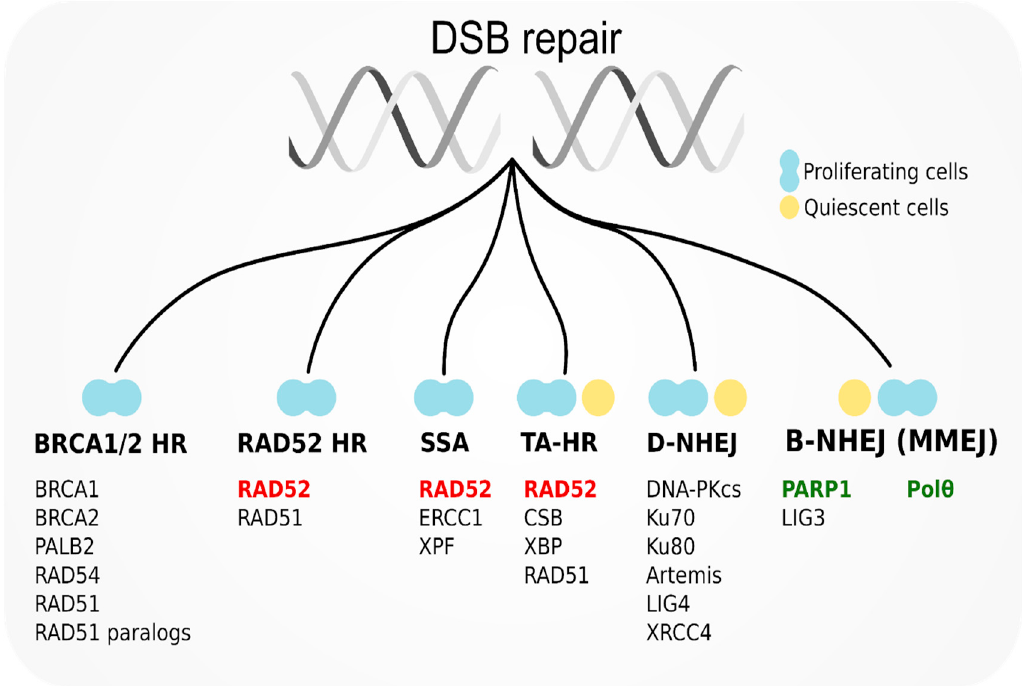
Figure 1. Double-strand break (DSB) repair mechanisms in quiescent and proliferating cells and major proteins participating in them. RAD52 as a potential target for synthetic lethality-based therapy has been marked in red. poly(ADP-ribose) polymerase 1 inhibitors (PARP1) and Pol θ —promising partners for dual synthetic lethality have been marked in green.